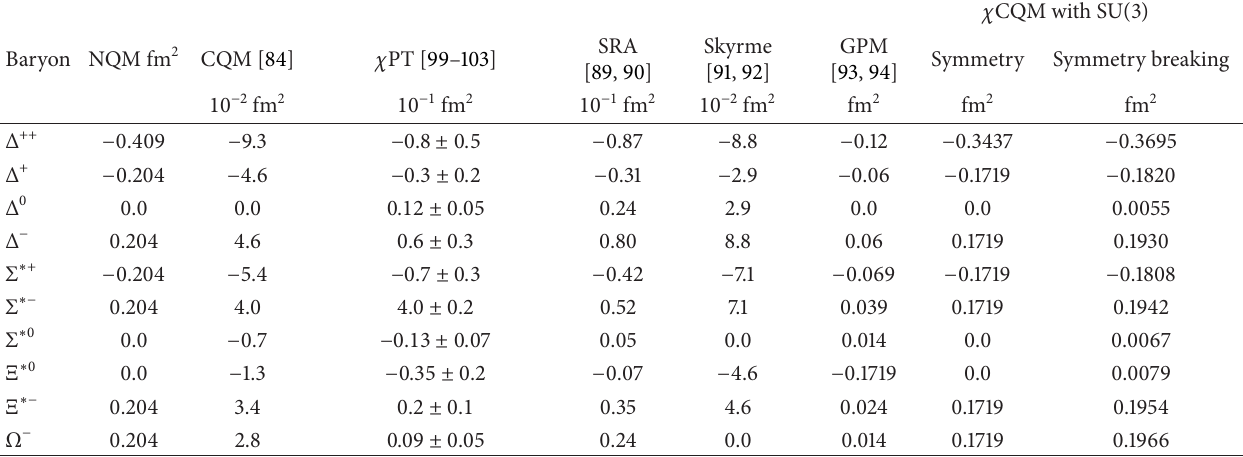
𝜒 CQM with SU (3)